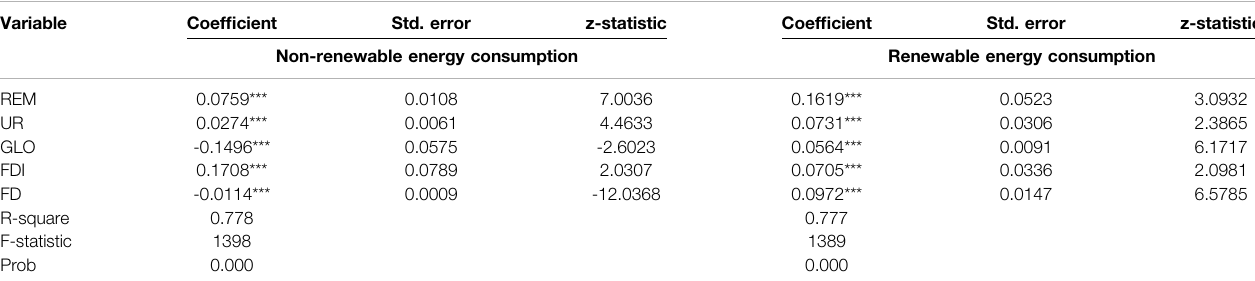
TABLE 6 | Results from panel